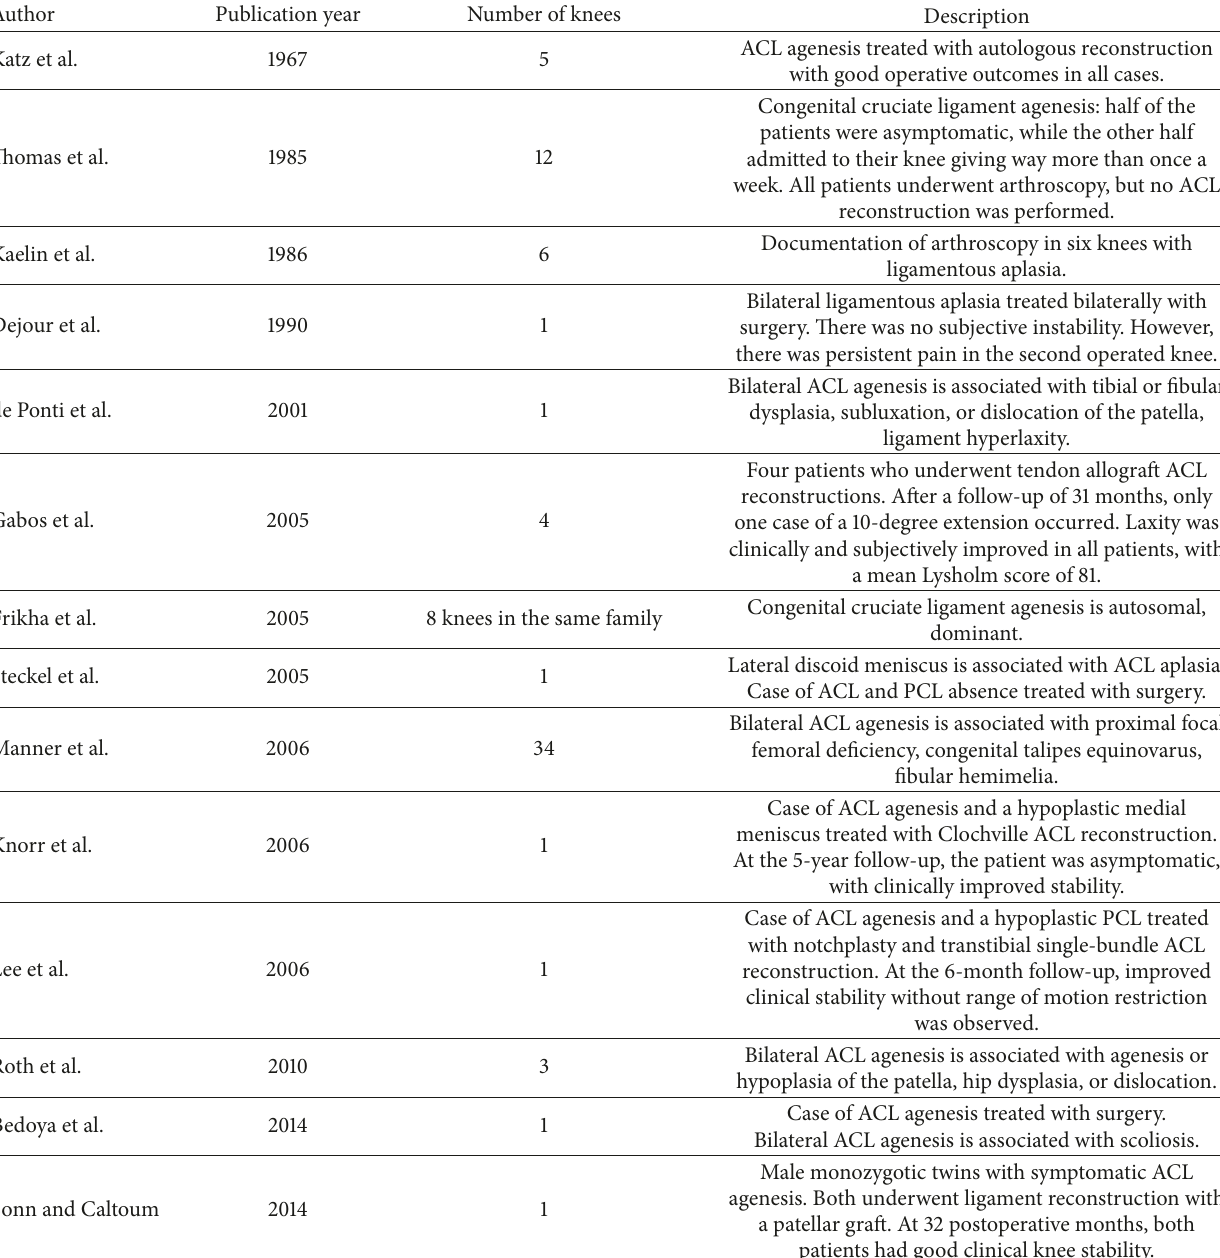
Table 2: Summary of published studies regarding the treatment of ACL